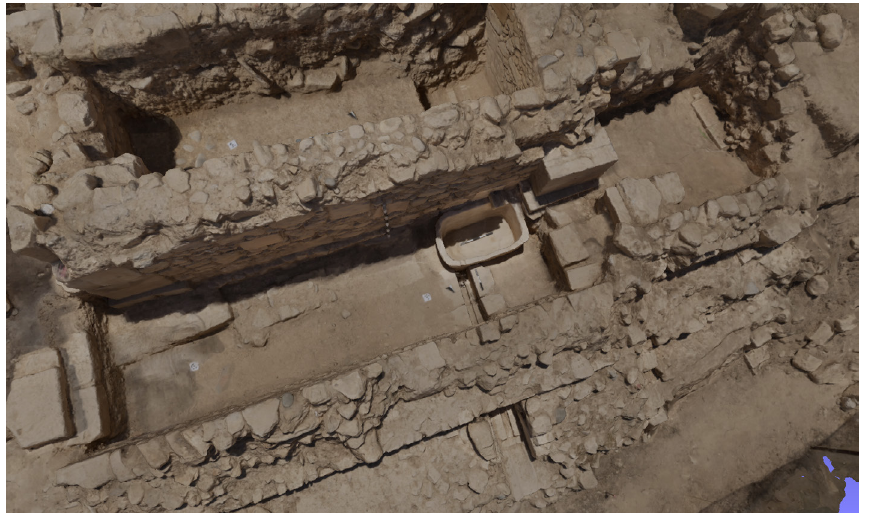
Figure 21. Hadjiabdoulla West Complex, Unit 6 installations between two retaining walls on north slope. 3D by V. Tringas